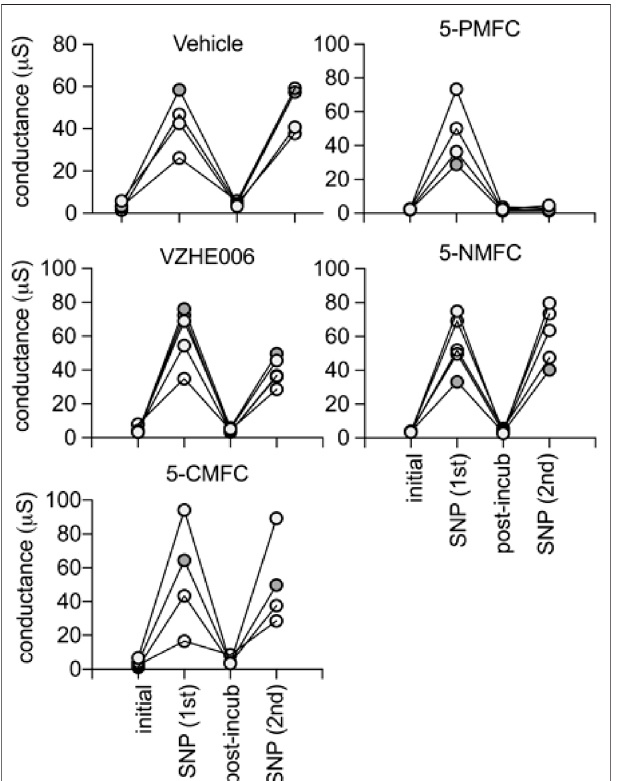
FIGURE 2 | Trend plots showing the amplitude of the ionic currents, before (initial) and after the fi rst activation by SNP (1st), the recovery after 2 h incubation with the indicated compound at 0.5 mM (post-incub), and the response reactivated by a second SNP application (2nd). Consistent recovery was seen after vehicle, 5-NMFC, or 5-CMFC but not after incubation with5-PMFCorVZHE006indicatingionchannelinhibition.Thenvaluesareas shown; each line represents a series of recordings from one oocyte.